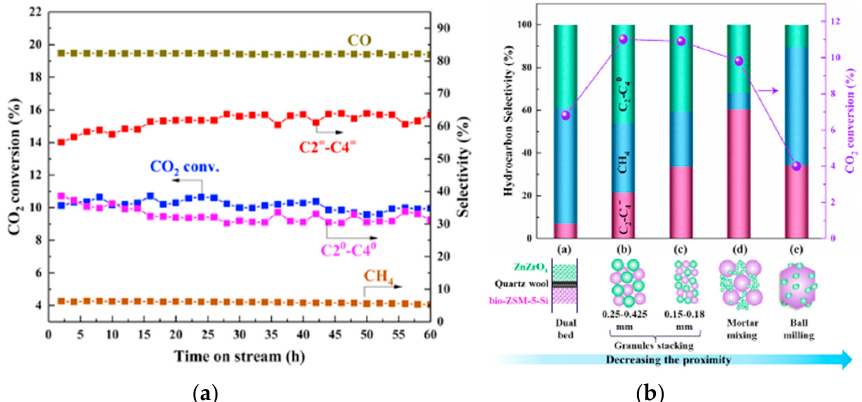
Figure 18. ( a ) Catalytic performance over the bifunctional composite catalysts ZnZrO x /bio-ZSM-5 − Si at TOS (testing conditions: mass of catalyst = 0.6 g, T = 653 K, P = 3 MPa, gas flow rate = 20 mL min − 1 ). ( b ) Effect of the proximity of the active components of ZnZrO x /bio-ZSM-5-Si on the catalytic performance. Adapted with permission from ref. [118]. Copyright 2021 American Chemical Society.